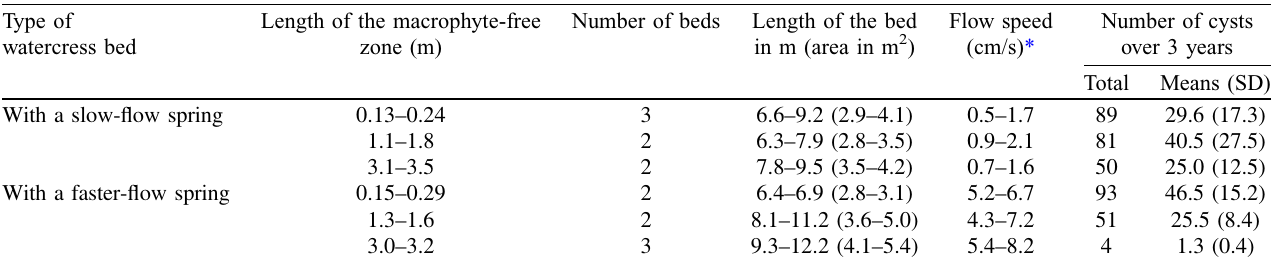
Table 1. Main characteristics of the 14 watercress beds studied in 2016 – 2018 in northern Haute Vienne, with indication of the number of Fasciola hepatica metacercariae.